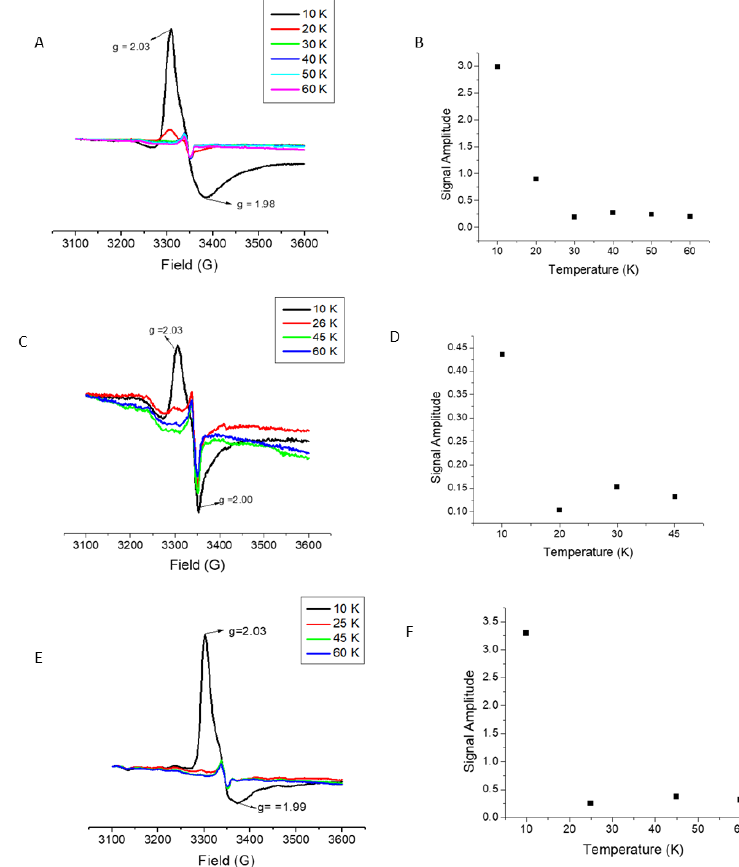
Figure 1. Shown above are the electron paramagnetic resonance (EPR) spectra obtained for reduced wild type lipoic acid synthesis (LIAS): ( A ) a single reducing cluster derivative; C137A ( C ); and the double reducing cluster derivative LIAS, C137A-C141A ( E ) are shown. The temperature dependence for each of the LIAS samples is shown beside their respective EPR spectra above in ( B ), ( D ) , and ( F ). Cys to Ala amino acid substitutions were made at each of the [4Fe–4S] cluster binding motifs to selectively eliminate binding at each of the reducing and auxiliary sites. The po- sitions of these substitutions are highlighted in Figure 2. Two Cys to Ala mutations were made in the reducing cluster site, C137A and C137A-C141A, where the double Cys to Ala mutation, C137A-C141A, was made to confirm the loss of cluster binding ability at the reducing cluster site after it was found that C137A LIAS alone was able to bind a [4Fe–4S] cluster. While the EPR spectrum might also be indicative of an oxidized [3Fe–4S] cluster, both the temperature dependence of the EPR signal and the absorption spectrum are only consistent with a [4Fe–4S] center. By use of the same methods of characterization as the wild type LIAS, it was determined that both of the reducing cluster site derivatives were bound to a [4Fe–4S] cluster, similar to wild type LIAS (Figure 1). A Cys to Ala mutation was also made in the auxiliary cluster binding site, C106A. After purification, the C106A derivative was found to contain no Fe–S cluster based on EPR data and Fe quantitation, and that the auxiliary site derivative, C106A, lacked any bound cluster (Supplementary Figure S1, Supplementary Table S1, and Supplementary Figure S2). These results were also supported by iron quantitation, which yielded results consistent with native LIAS